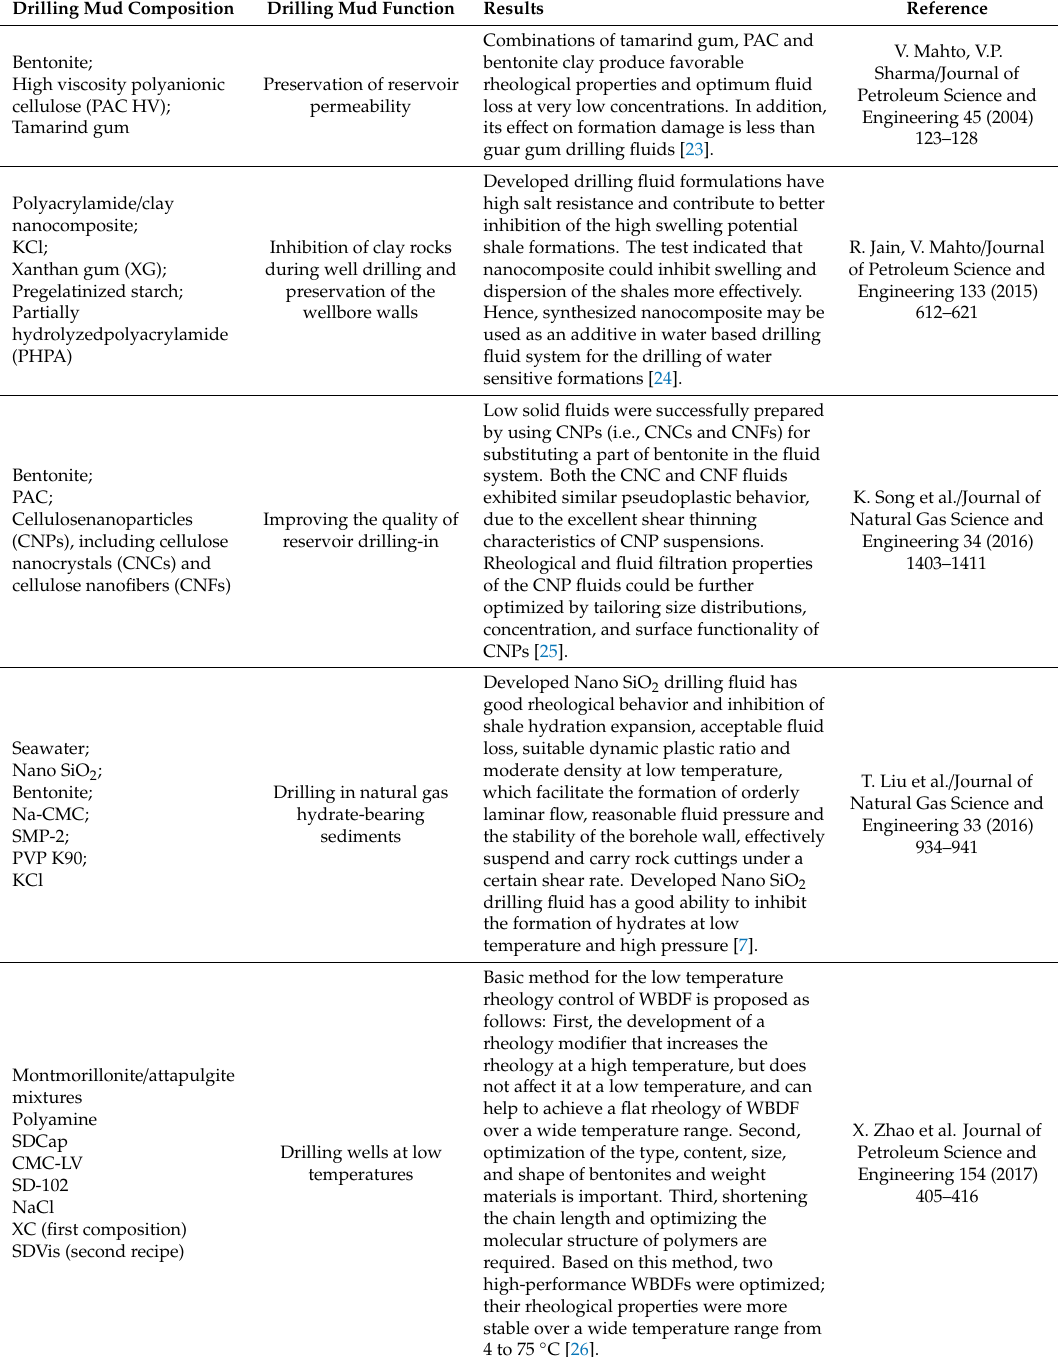
Table 1. Investigation of various compositions for polymer drilling